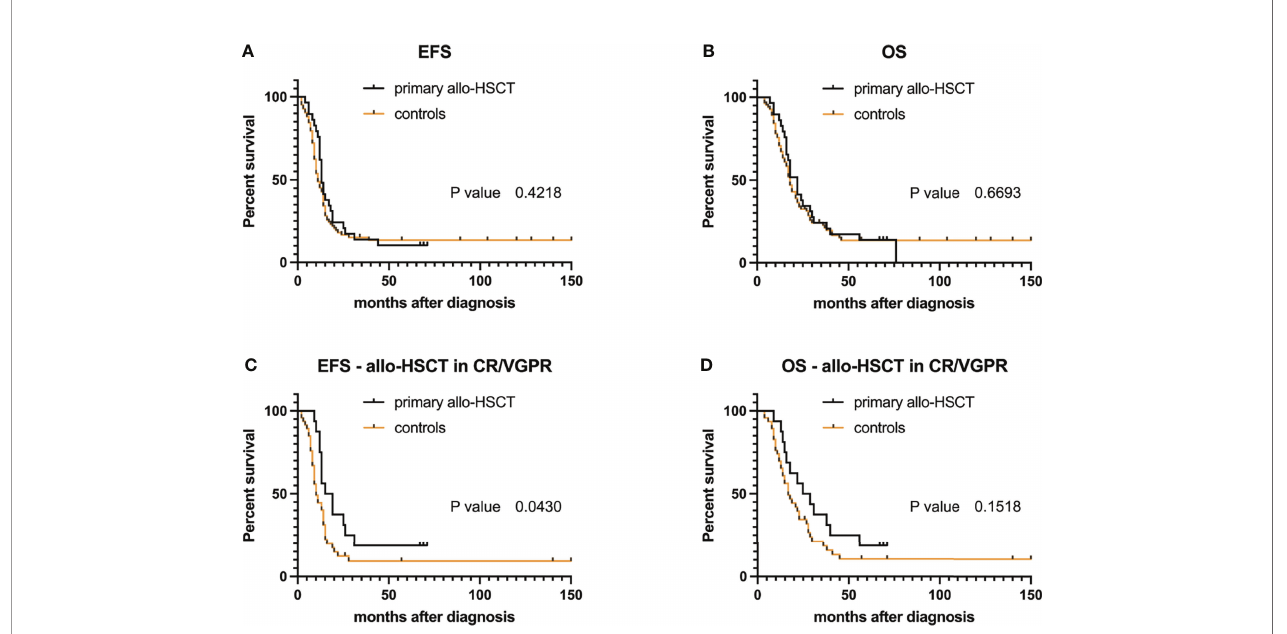
FIGURE 4 | Event-free survival (EFS) and overall survival (OS) probabilities after allogeneic hematopoietic stem cell transplantation (allo-HSCT) compared to matched non-transplanted controls: for all 29 primary transplanted RMA patients (A, B) . (C, D) EFS and OS probabilities for patients with CR/VGPR at time of allo-HSCT ( n =